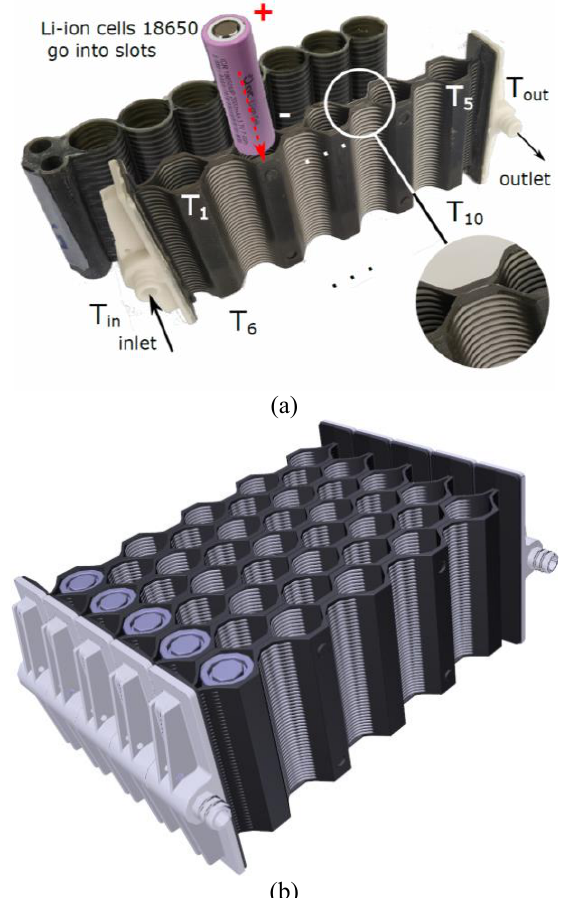
Fig. 1. A polymer heat exchanger with hollow fibers as coolant channels (a) – the preliminary (back) [18] and the progressed (front) prototype; a compact assembly for a battery module (b) with the first row of Li-ion cells inserted.